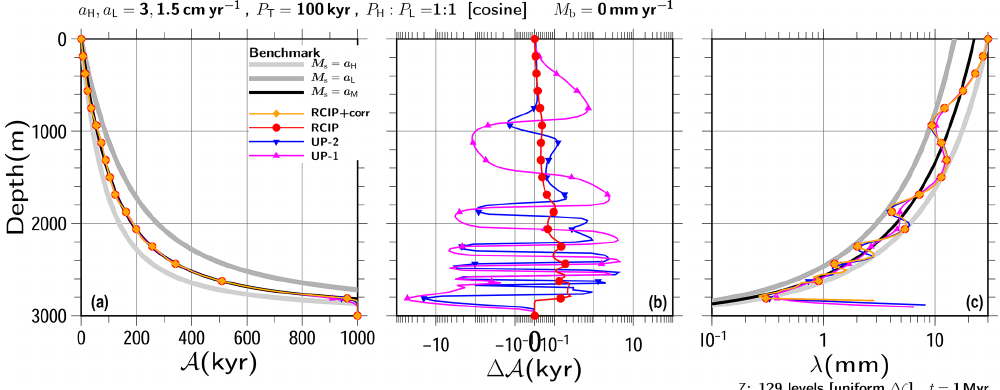
Figure 9. Same as Fig. 7 but for the results of transient experiments conducted with a cosine-wave surface mass balance of a H ,a L = 3 and 1.5cmyr − 1 .